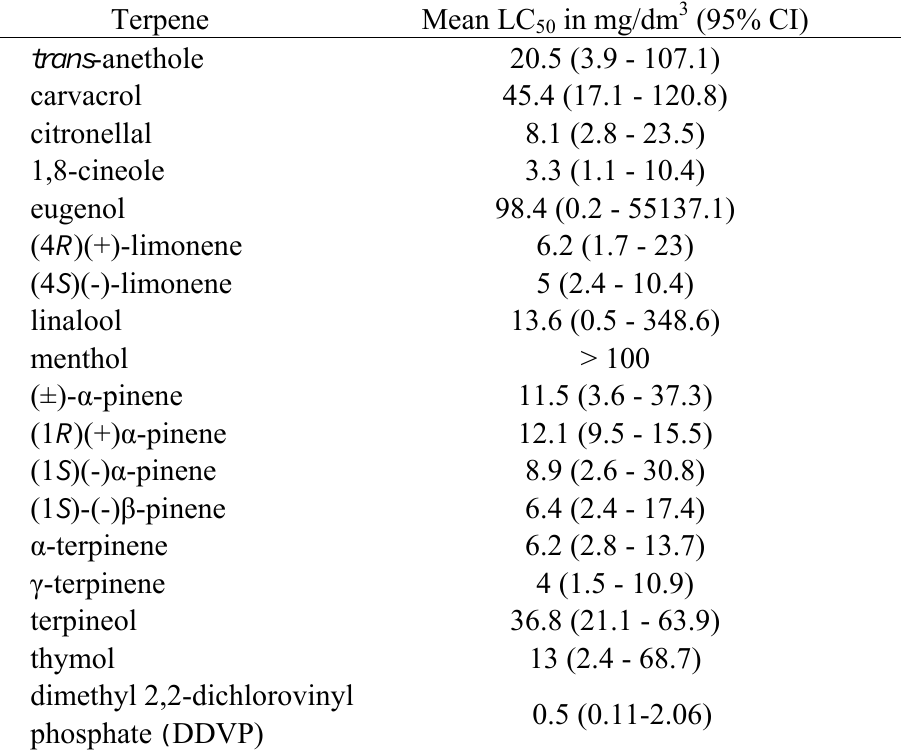
s of selected terpenes against Musca Table 3. LC 50